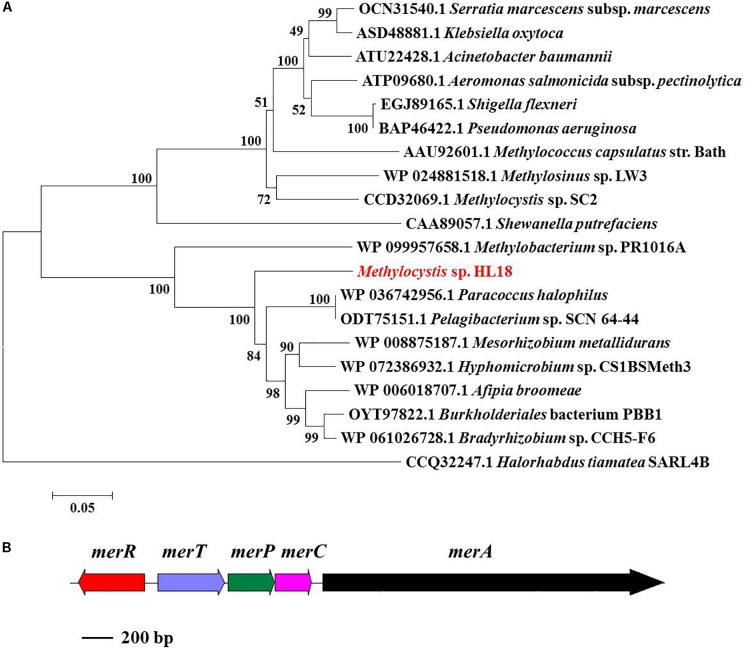
(A) Phylogenetic tree of MerA based on amino acid sequences and (B)
mer operon containing five genes (merR, merT, merP, merC, and merA). MerA of archaea Halorhabdus tiamatea was used as the outgroup member of this tree. Numbers indicated the bootstrap support (1000 replicates).